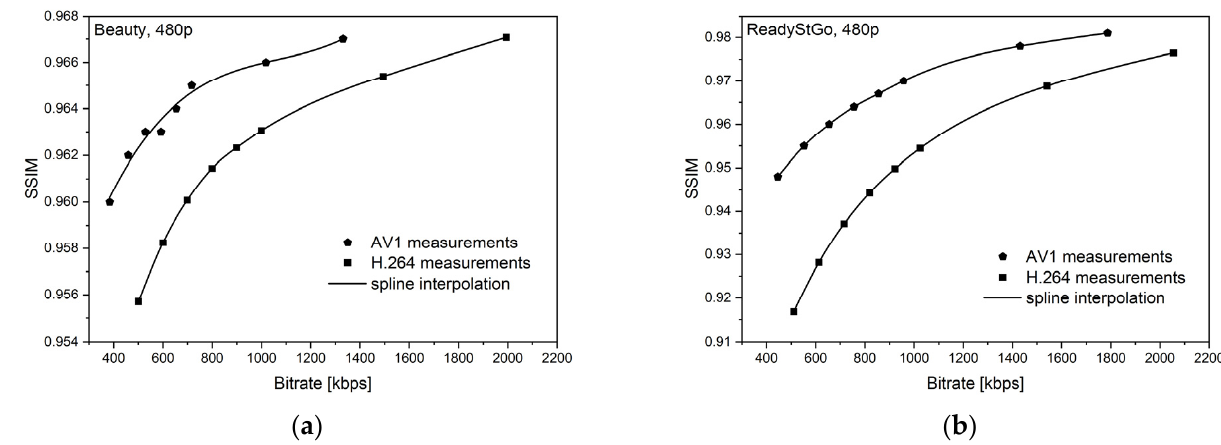
Figure 10. Comparison of the H.264 and AV1 codecs, based on the SSIM metric, for two different videos: ( a ) slow motion video; ( b ) fast motion video.